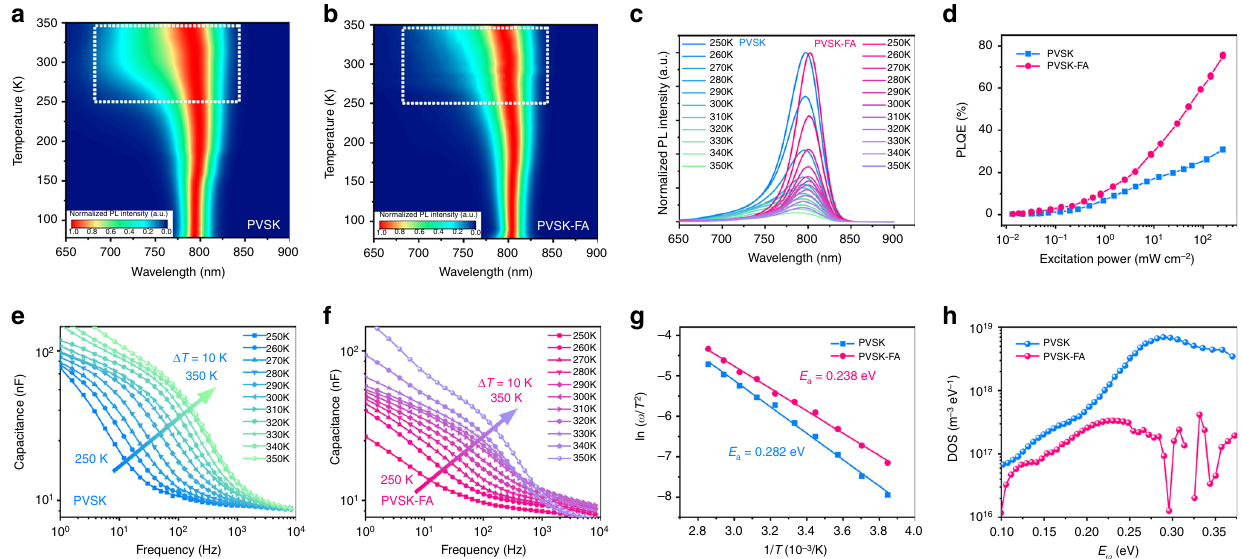
Fig. 4 Weak alkaline additives to reduce defect state density. Color plots of normalized steady-state PL spectra for ( a ) PVSK and ( b ) PVSK – FA at different temperatures from 78 to 350 K. c Corresponding steady-state PL spectra for both fi lms at various temperatures from 250 to 350 K. d The PL quantum ef fi ciency of PVSK and PVSK – FA fi lms as a function of excitation power. The admittance spectra of the ( e ) PVSK and ( f ) PVSK – FA devices measured at a temperature from 250 to 350 K with a step of 10 K. g The corresponding Arrhenius plots of the characteristic frequencies to extract the defect activation energy ( E a ) for both devices. h Trap density of states (tDOS) for both devices obtained by thermal admittance spectroscopy at room